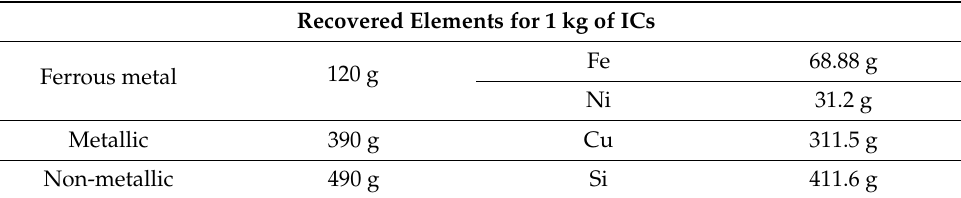
Table 1. Physical processing of the discarded integrated circuit (IC) outcomes